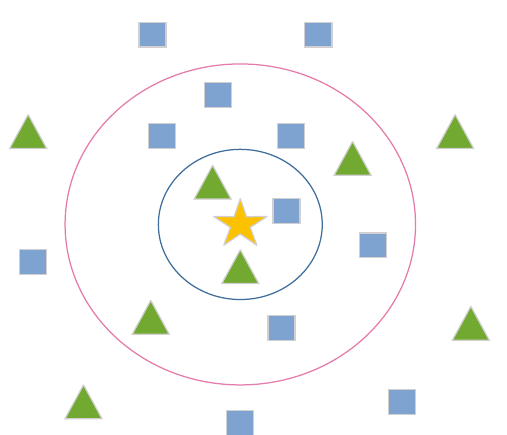
Figure 3: K -nearest neighbor